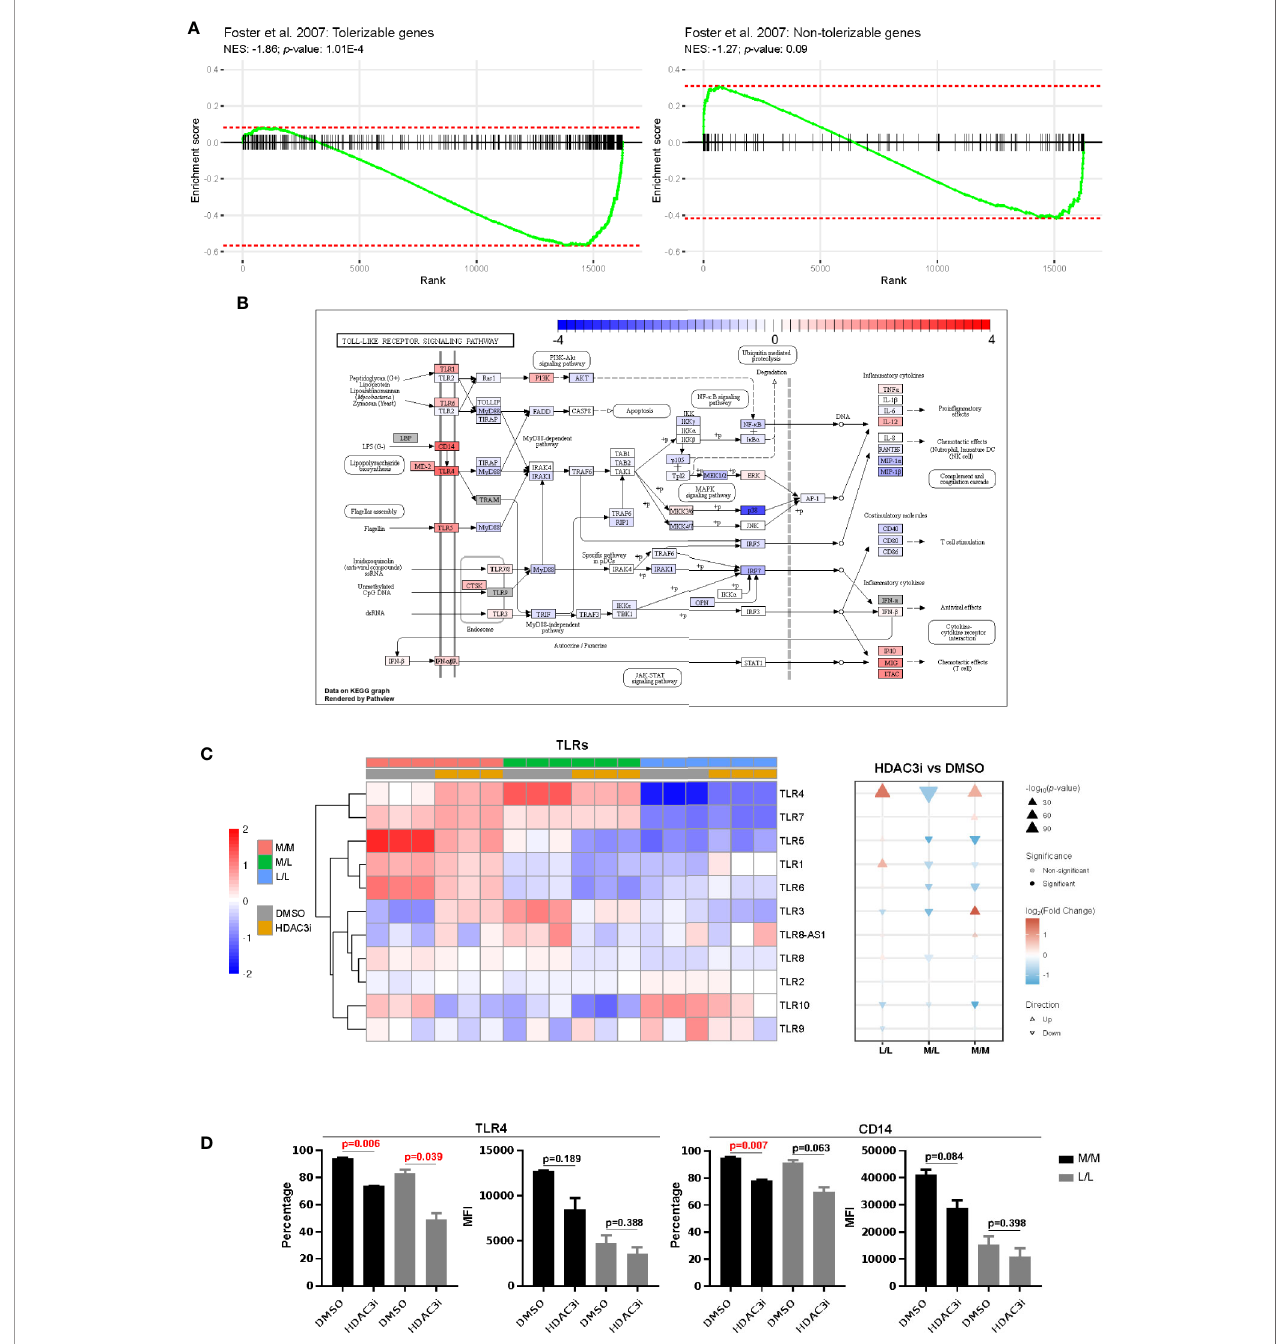
FIGURE 5 | Comparison of the tolerized versus non-tolerized M1 macrophages derived from HDAC3i-pretreated CD14 + monocytes with the tolerized versus non- tolerized M1 macrophages derived from HDAC3i-pretreated CD14 + monocytes. An interaction analysis was performed to identify genes that displayed differential expression when comparing tolerized with non-tolerized for M1 macrophages derived from DMSO- or HDAC3i-treated primary human CD14 + monocytes (n=3). (A) Gene set enrichment analysis performed on the tolerizable and non-tolerizable gene sets as de fi ned by Foster et al. in mice. (B) The KEGG Toll like receptor signaling pathway with colors representing the effect size obtained from interaction analysis. (C) Heatmap and gene set enrichment analysis of TLRs in “ M/M ” , “ M/L ” and “ L/L ” macrophages. (D) FACS analysis of TLR4 and CD14 in “ N ” and “ NT ” M1 macrophages derived from DMSO-treated or HDAC3i-treated primary human CD14 + monocytes. Data is presented as percentage or mean of fl orescence intensity